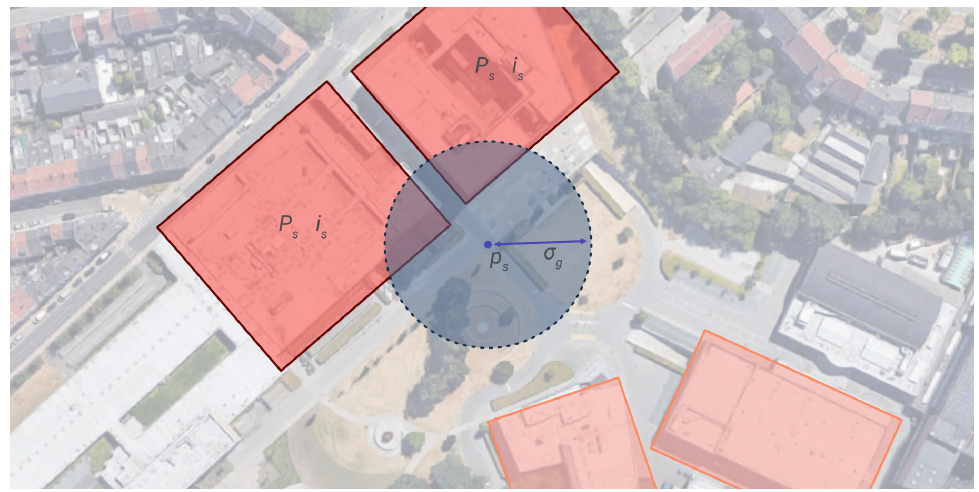
Figure 4. Overview of the global alignment process between the reference datasets (red) and test dataset (blue) to establish a sub-selection of reference data with center p s and error radius σ g